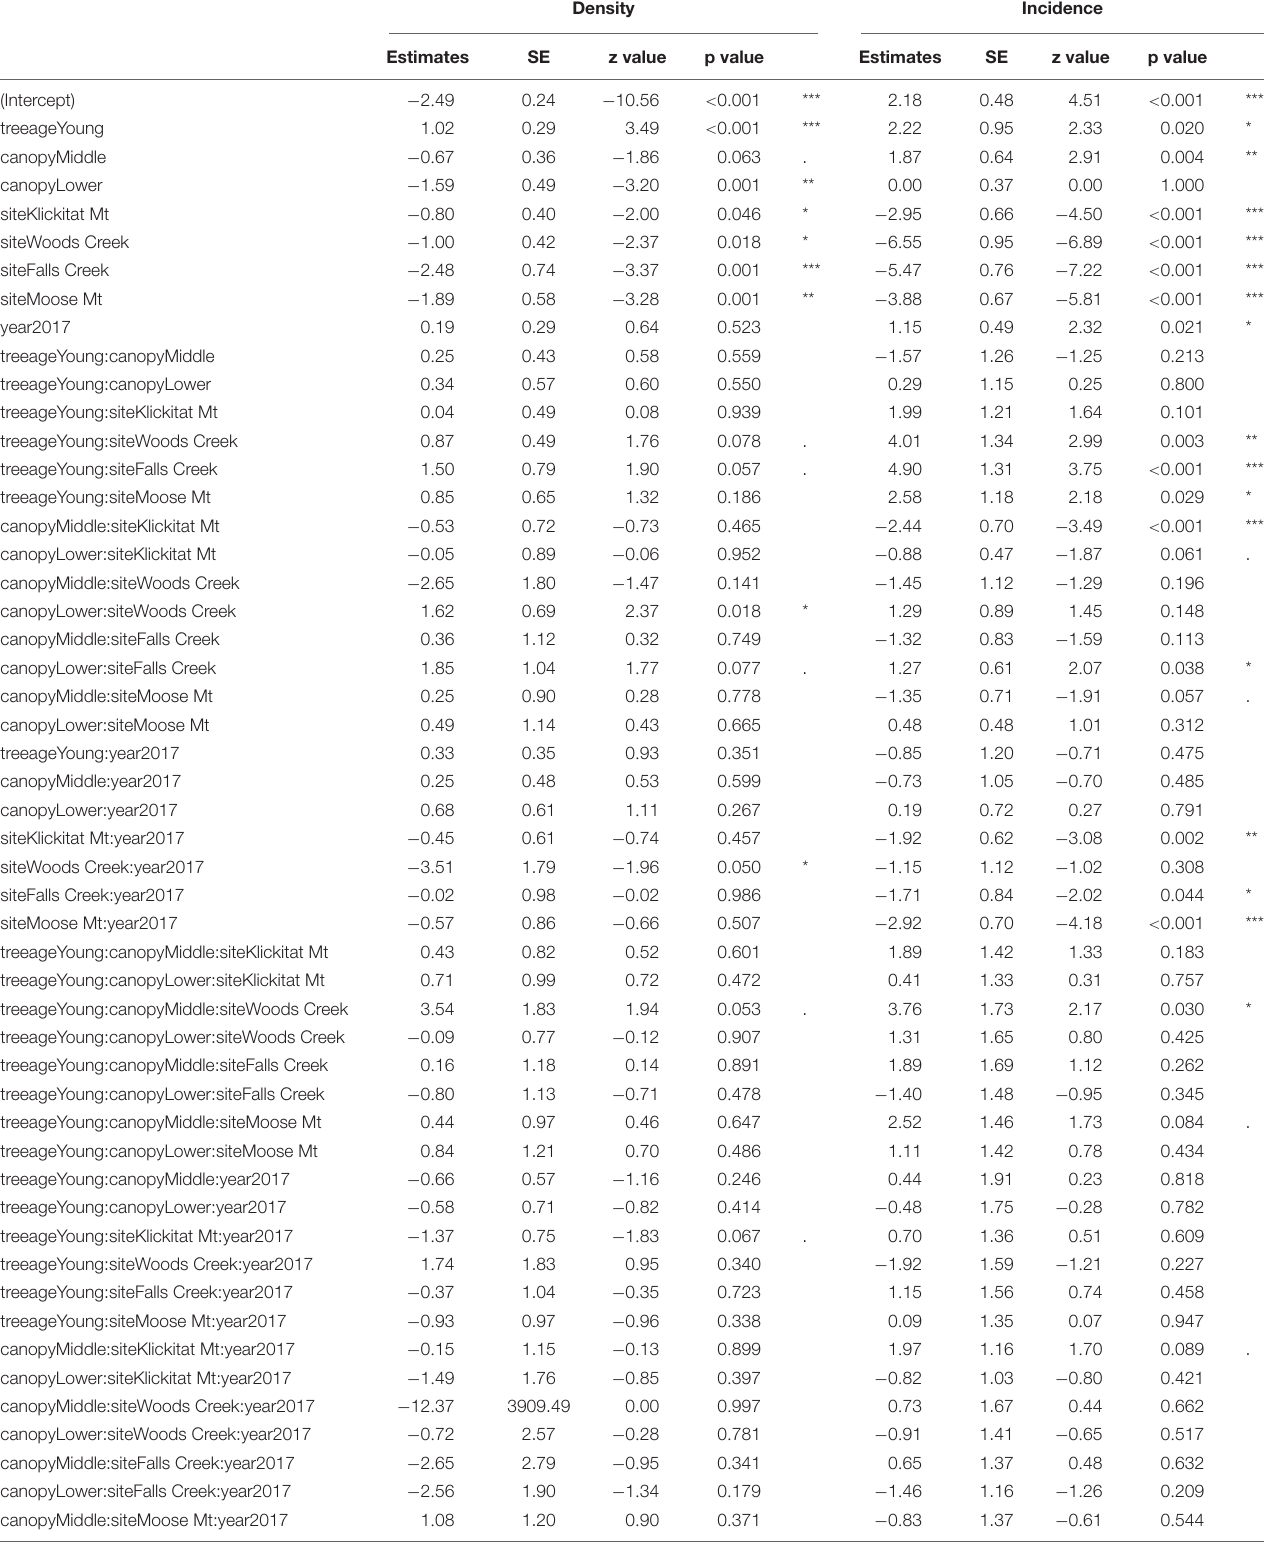
TABLE 1 | Summary of GLMM of pseudothecia incidence and density, across five study sites (15 trees) in western Oregon, tree age (mature or young trees), year, canopy positions and their interactions. Density